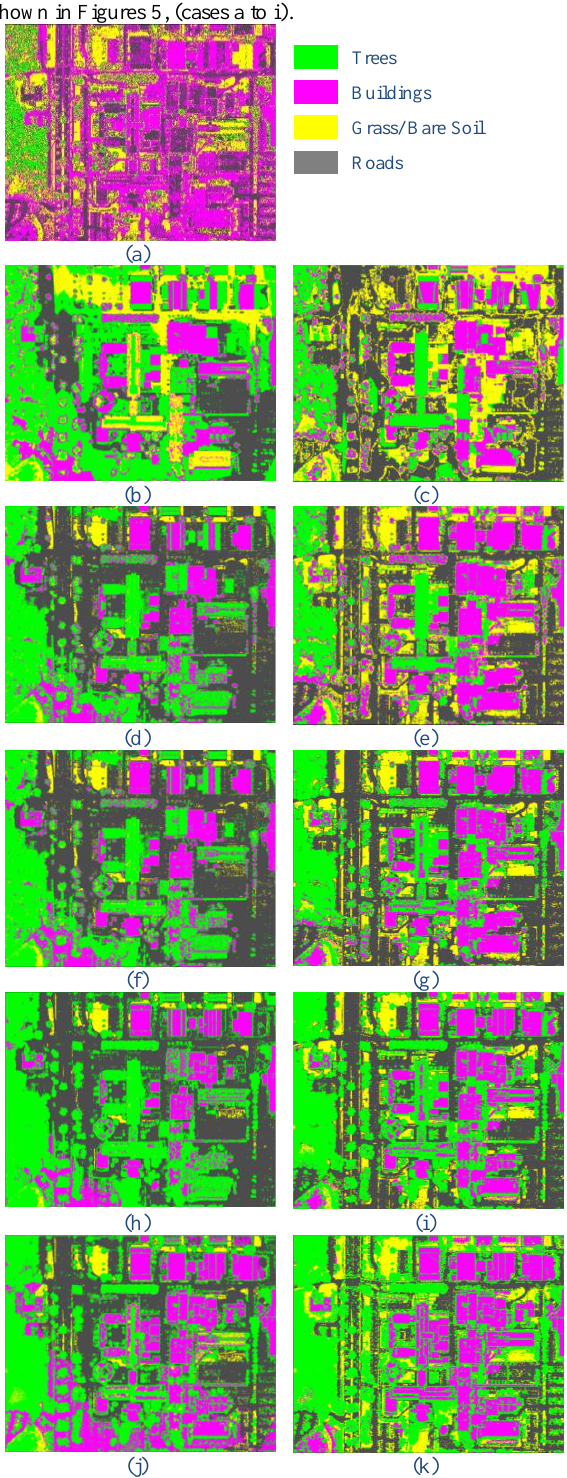
Figure 5: Results of Land Cover